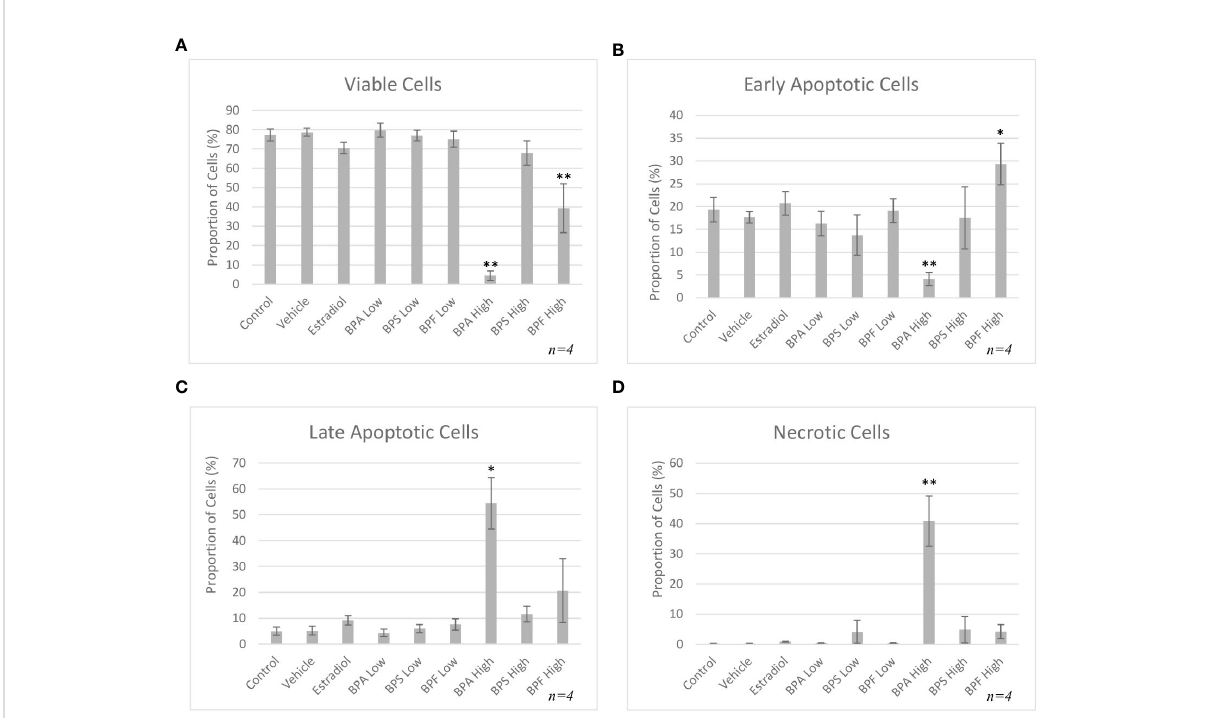
FIGURE 4 Apoptosis rates of bovine granulosa cells at 48 hours. This was detected by Annexin V-FITC/PI staining and fl ow cytometry. Columns represent the proportion (A) viable cells, (B) early apoptotic cells, (C) late apoptotic cells and (D) necrotic cells following treatment with BPA, BPS and BPF at two different concentrations for 48 hours. *p<0.05 and **p<0.01 compared to controls was considered as statistically signi fi cant. Error bars represent +/-